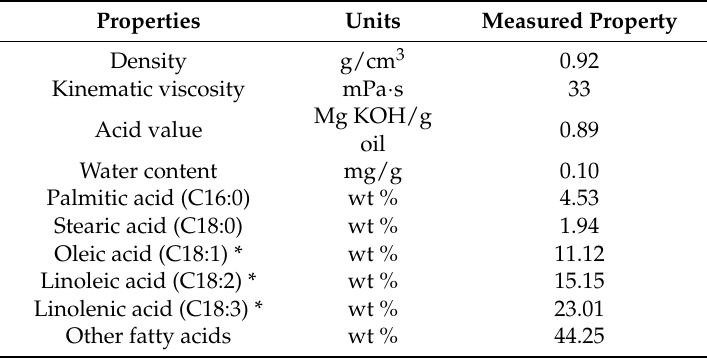
Table 5. Chemical and physical properties of the used